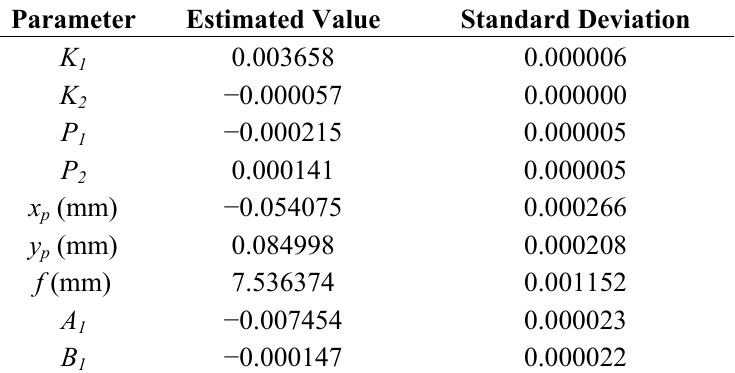
Table 3. Digital camera parameters from pre-calibration process.